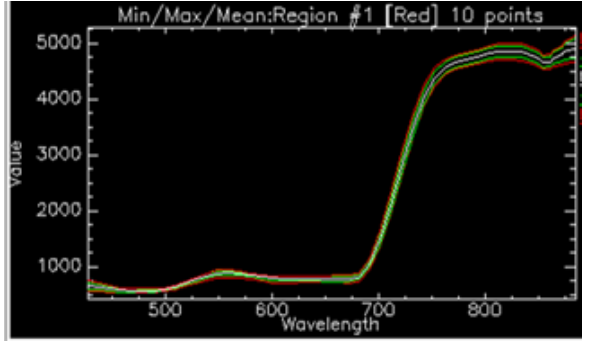
Figure 5. Cannabis Spectral profile of extracted endmembers Cannabis detection results were represented in figures 6 for Hyperion data of 2003, figure 7 of 2009 Hyperion data in Morocco for positive Cannabis detection and figure 8 represented the Hyperion data of Algeria in 2004. Positive Cannabis results were obtained from Moroccan sites represented in red in figures 6 and 7. Whereas, no Cannabis detection was revealed from Algerian data in figure 8.